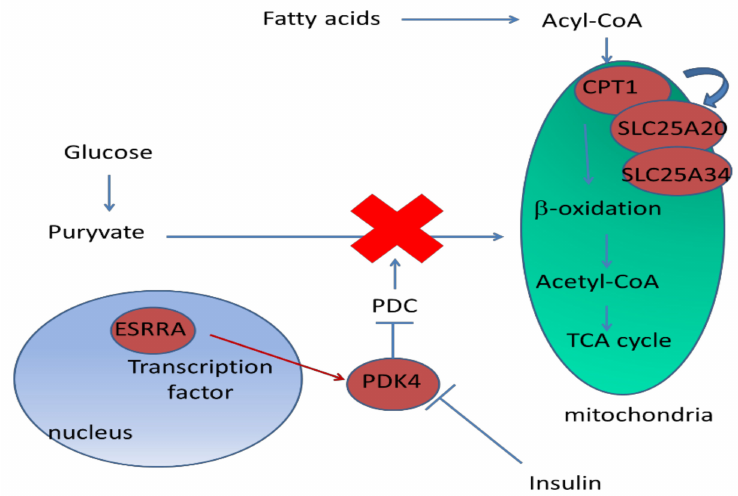
Figure 4. Upregulation of genes detected at mRNA level highlights a potential increase of fatty acid oxidation. Red boxes indicate upregulated genes. Blue and green boxes represent the nucleus, and mitochondria, respectively. Carnitine O-palmitoyltrasferase 1 (CPT1A) encodes carnitine O-palmitin O-palmitoyltranferase 1, Mitochondrial Carnitine/Acylcarnitine Carrier Protein (SLC25A20) and Solute Carrier Family 25 Member 34 (SLC25A34) are two members of the solute carrier family 25. Steroid Hormone Receptor ERR1 (ESRRA) and Pyruvate Dehydrogenase Acetyl-Transferring Kinase Isozyme 4 (PDK4) encode a steroid hormone receptor and a pyruvate dehydrogenase,